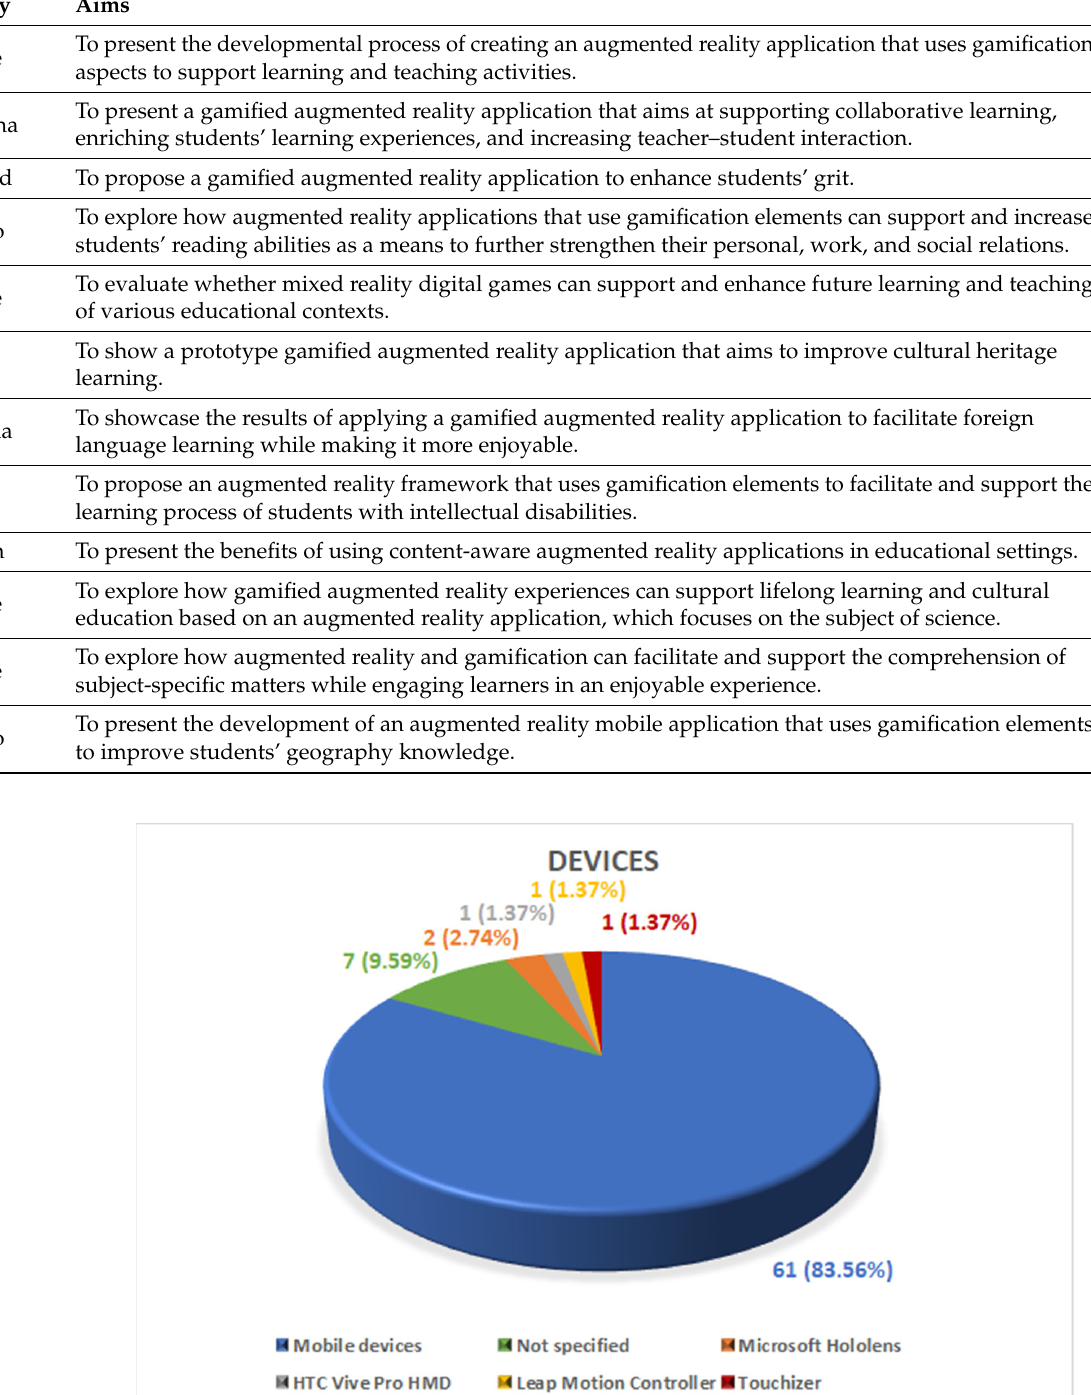
Table 5. Proposal and prototype papers: general information.